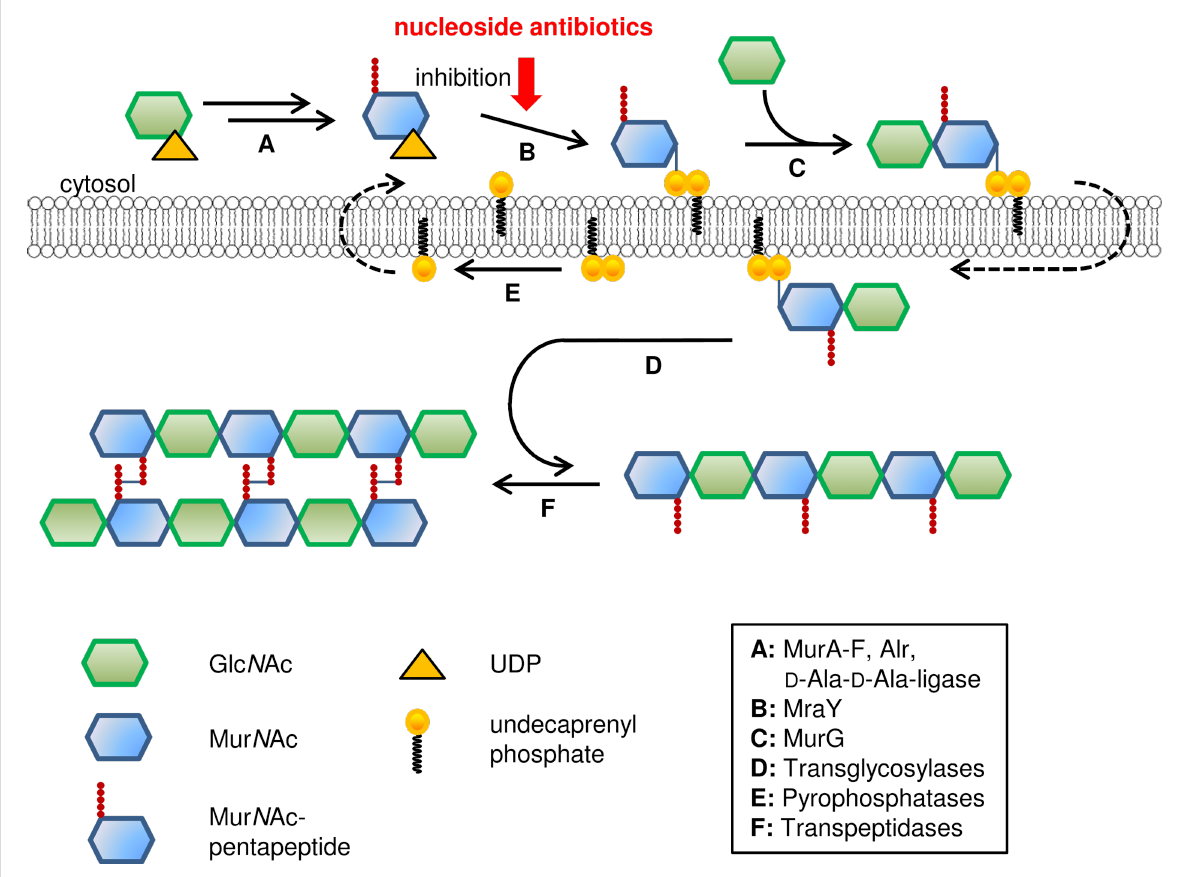
Figure 4: Schematic representation of bacterial cell wall biosynthesis.